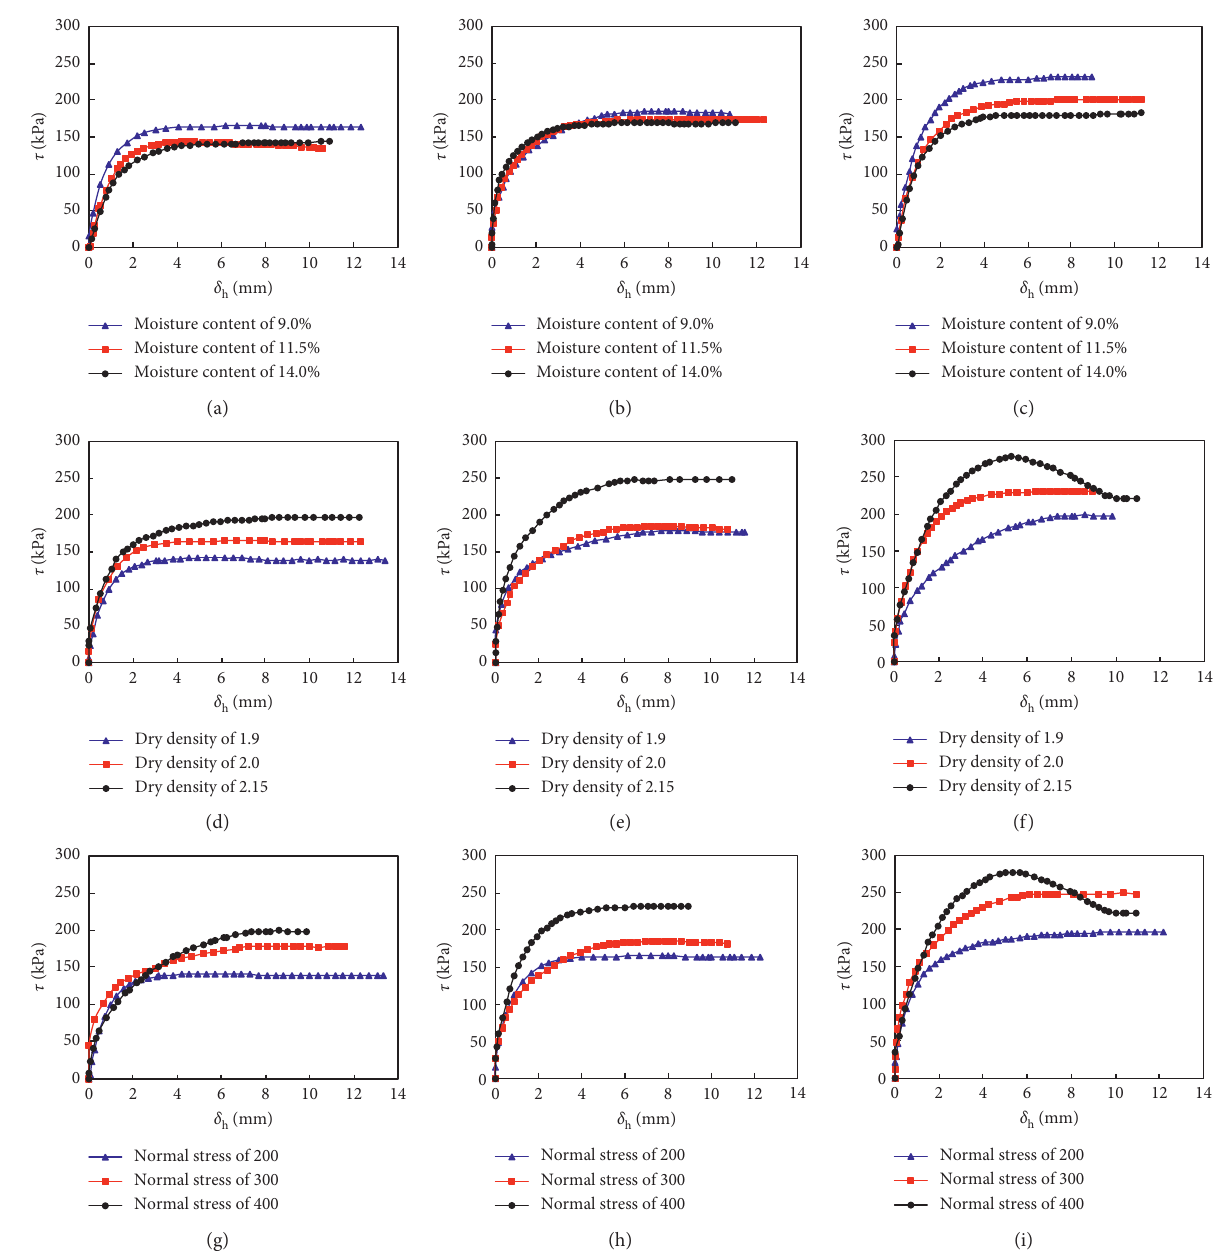
Figure 5: Relationships between shear stress ( τ ) and shear displacement ( δ (c) ρ d � 2.0g/cm 3 , σ � 400kPa. (d) w � 9.0%, σ � 200 kPa. (e) w � 9.0%, σ � 300kPa. (f) w � 9.0%, σ � 400 kPa. (g) w � 9.0%, ρ d � 1.9g/cm 3 . (h) � 2.0g/cm 3 . (i) w � 9.0%, ρ � 2.15g/cm 3 w � 9.0%, ρ d d